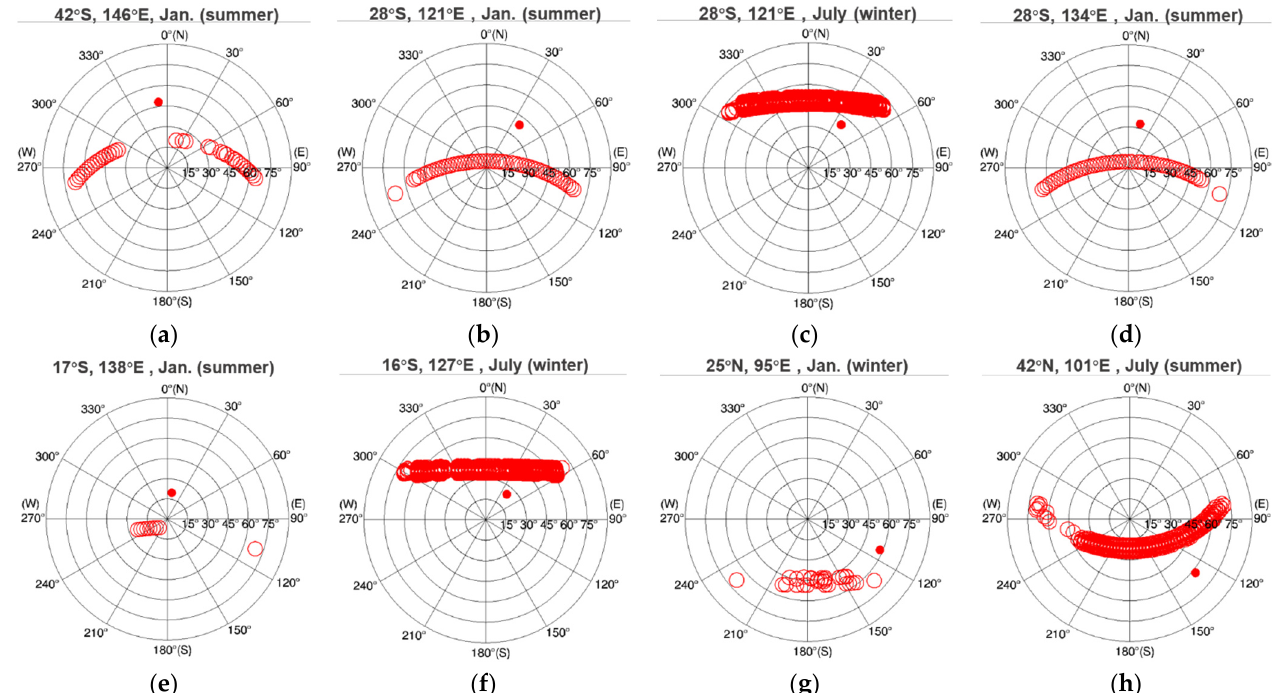
Figure 7. The typical angle distribution for the monthly accumulated AHI data within the observation scope. The latitude, longitude, and month are labelled in each plot. ( a – f ) refer to the results in the southern hemisphere, and ( g , h ) shows those in the north.